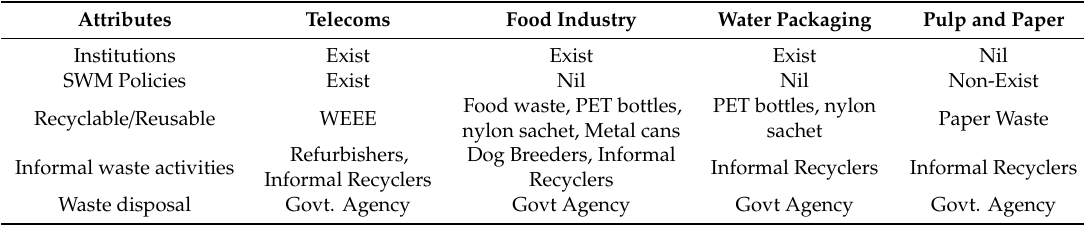
Table 1. Summary of CE attributes of the selected industries. Source: The authors’